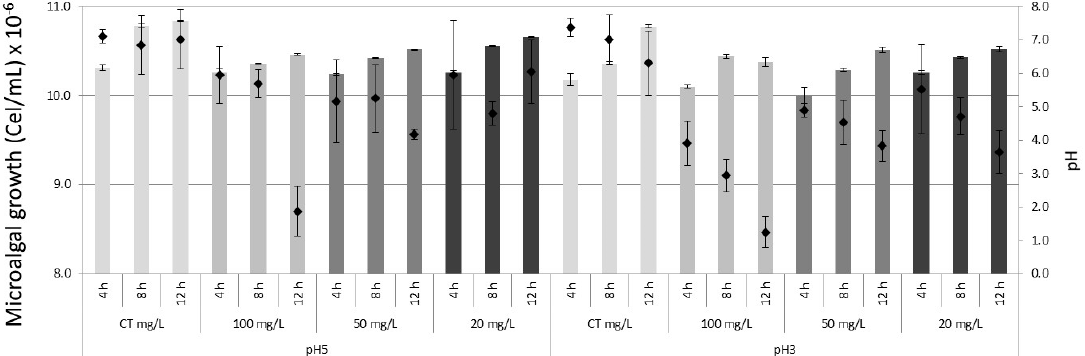
Figure 2. Growth of the microalga Muriellopsis sp. in artificial acid drainage (AAD) cultivated at different pH and zinc concentrations. CT (Control). The bars represent ± standard error of the mean. Diamond symbol microalgal growth.